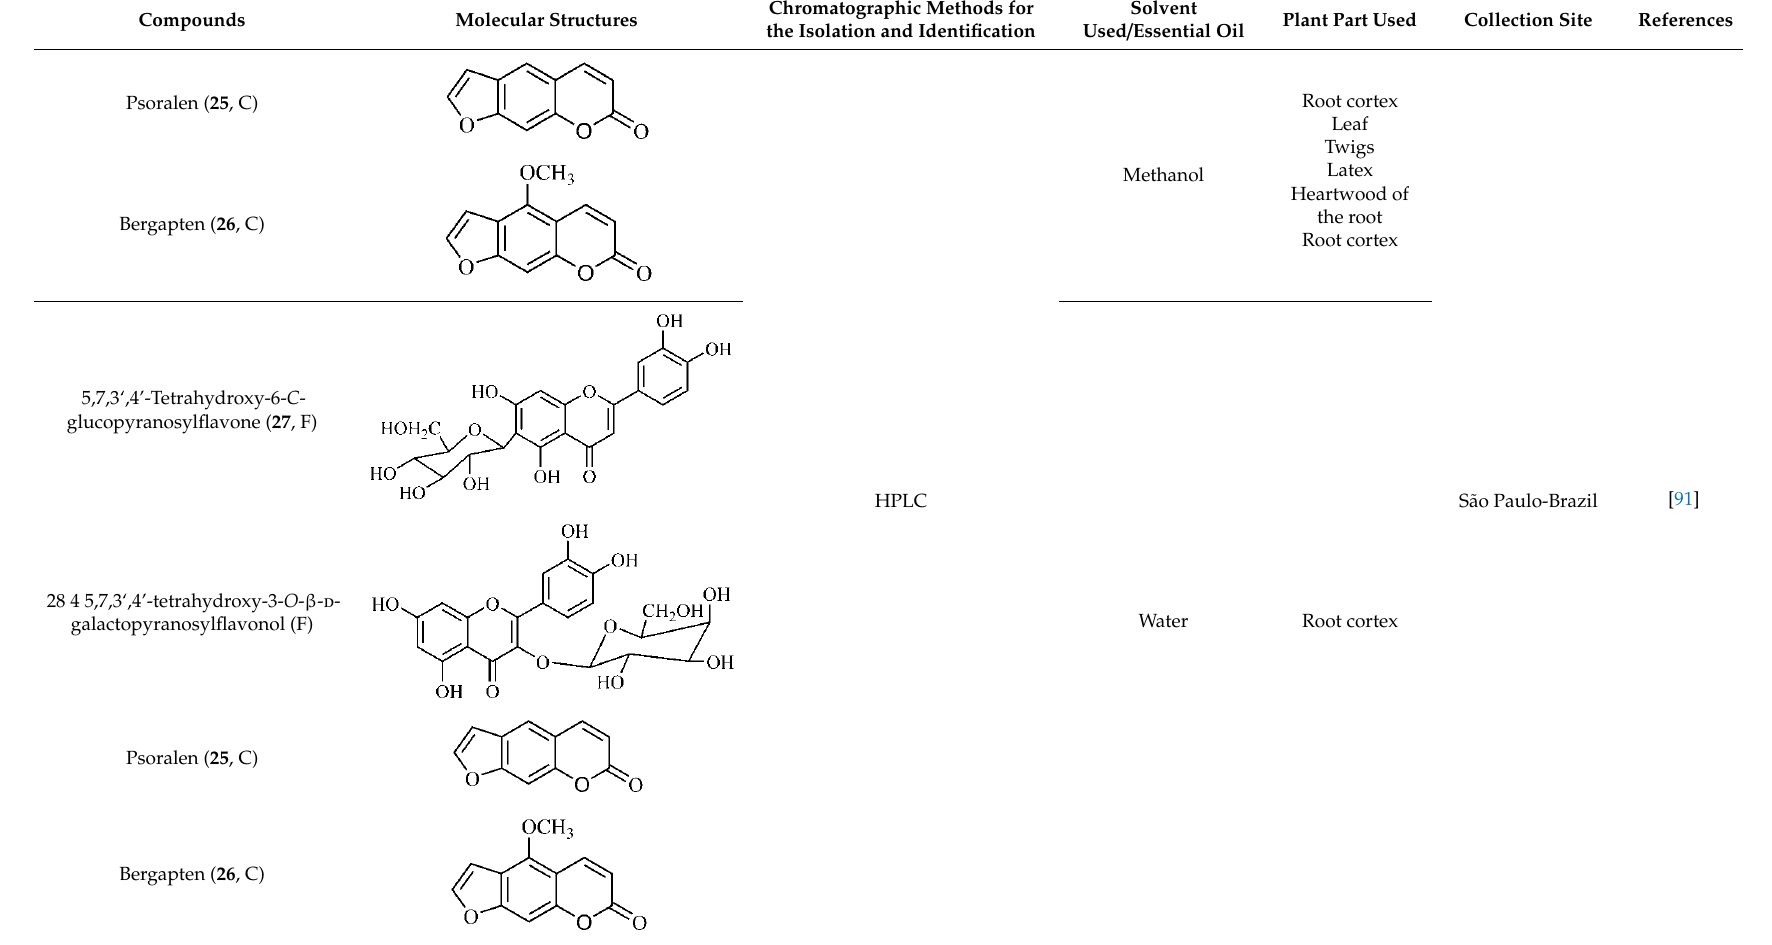
Table 2. Phytochemical analysis of B. gaudichaudii .